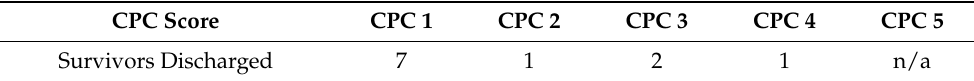
Table 2. Cerebral Performance Score after one year in patients who presented with myoclonic status but did not display status epilepticus on